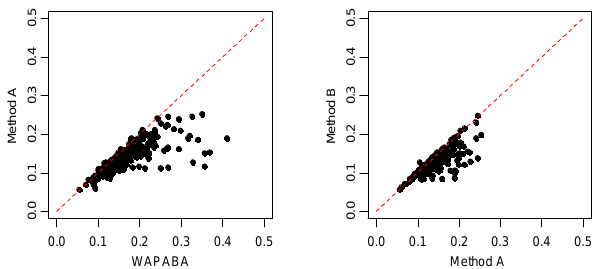
Fig. 9. Scatter plots of RMSEP values; (left) WAPABA predictions vs. method A, (right) method A vs. method Figure 9: Scatter plots of RMSEP values; (left) WAPABA predictions vs. Method A, (right) Method 527 A vs. Method B. 528